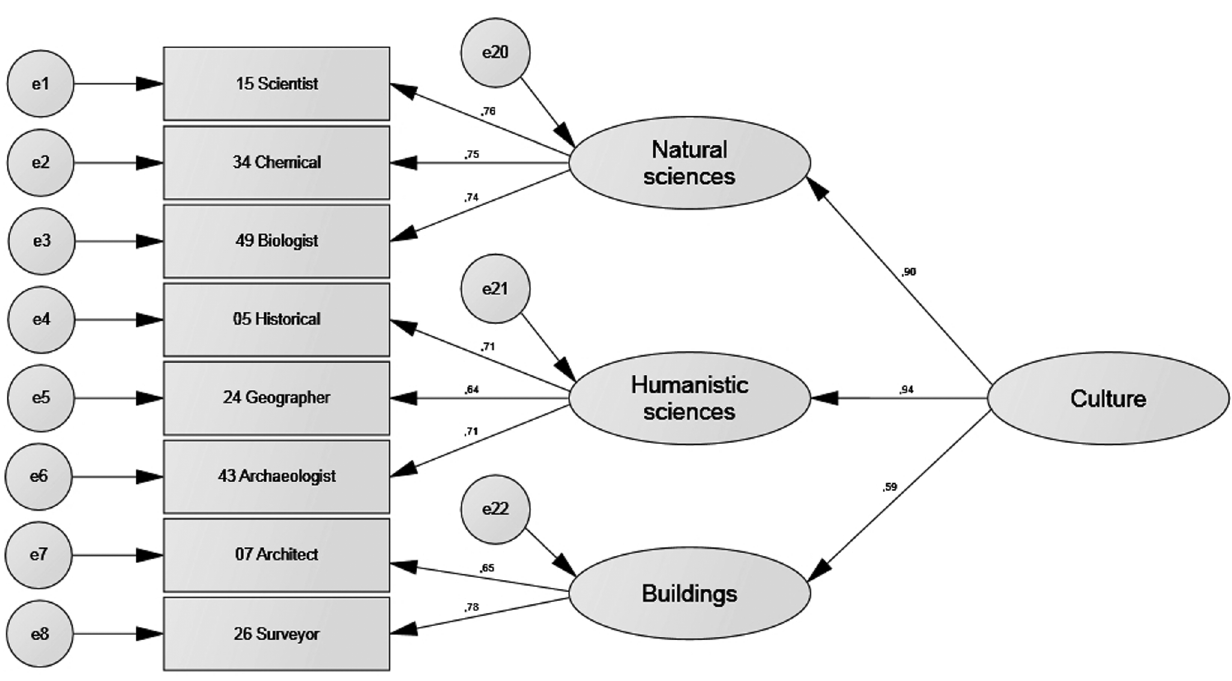
Figure 4. Standardised estimates for the culture factor.